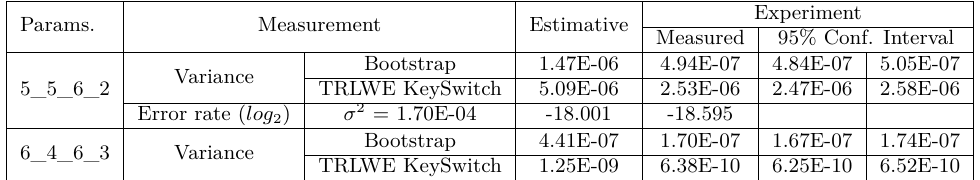
Table 3: Experimental validation for the variance and error rate for two sets of parameters.